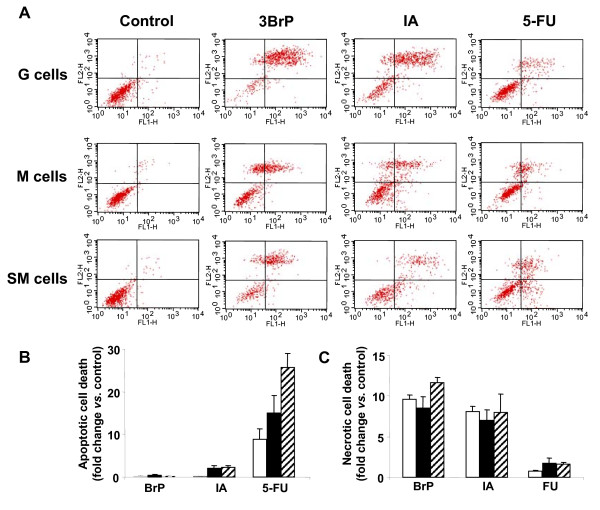
The Bioenergetic Signature correlates with the cell-death pathway in response to chemotherapy . HCT116 cells were treated as indicated [11] to produce cells with low (G-cells), medium (M-cells) and high (SM-cells) bioenergetic signatures. Cells were then treated with the following agents: 8 μM 3BrP, 100 μM IA, 10 μM 5-FU or left untreated (Control). A, Representative FACS analysis of cells after annexinV-FITC (50 μg/mL) and propidium iodide (100 μg/mL) staining are shown. The lower left quadrant corresponds to viable cells; the lower right quadrant early-apoptotic (annexin-positive) cells and the upper right and left quadrants corresponds to dead (PI positive) cells. Histograms shown are the means ± SEM of the percentage of apoptotic (annexin V positive) (B) and necrotic (PI positive) cells (C) from 4-6 independent determinations in G- (open bars), M- (closed bars) and SM-cells (hatched bars). *, p < 0.05 for multiple comparisons by ANOVA and post hoc Dunnett's test.